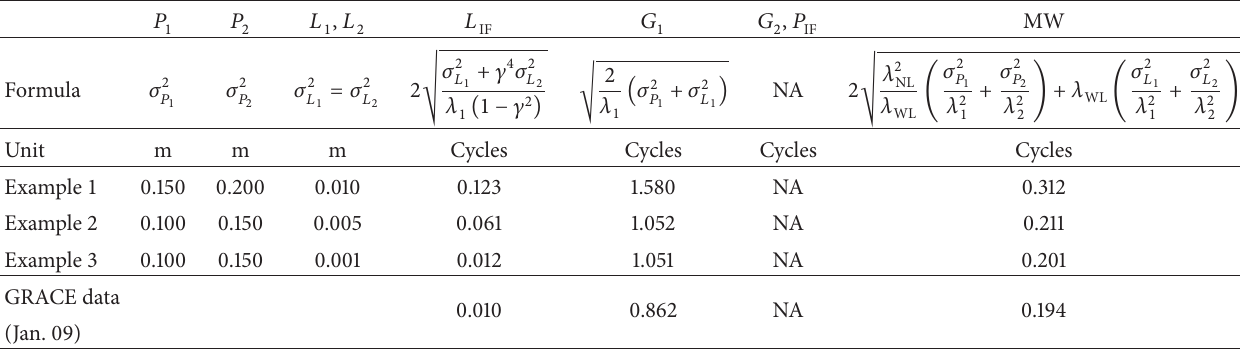
Table 2: Expected and estimated standard deviations of the various combinations for 𝑁 1𝑗𝑘 estimation (NA: not